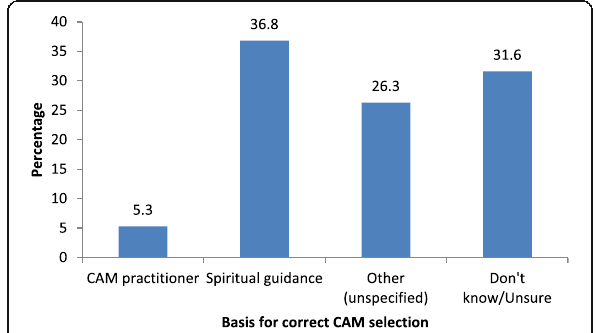
Fig. 3 Basis for appropriate CAM use. CAM, complementary and alternative medicine